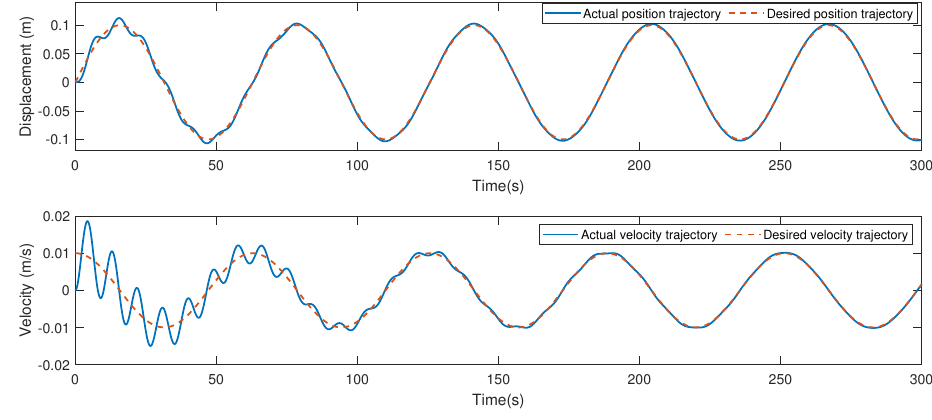
Figure 17. The position and velocity trajectory of the robot.